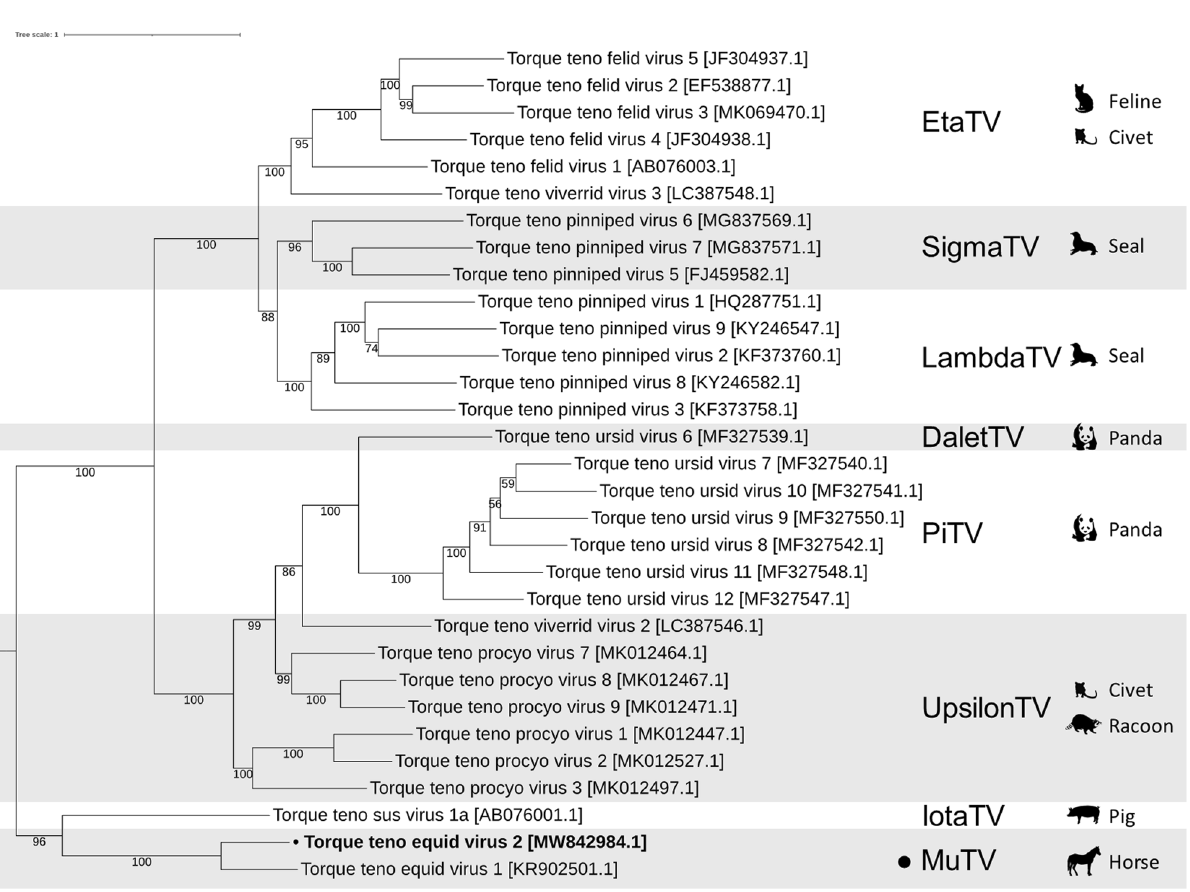
Figure 1. Maximum likelihood phylogenetic trees of representative torque teno viruses. ORF1 amino acid sequences were aligned using MAFFT 31 , trees generated using IQ-TREE 33 on find best model setting with ModelFinder 34 (VT + F + R6 model selected) with 1000 ultrafast bootstraps 35 and visualized using iTOL 36 .